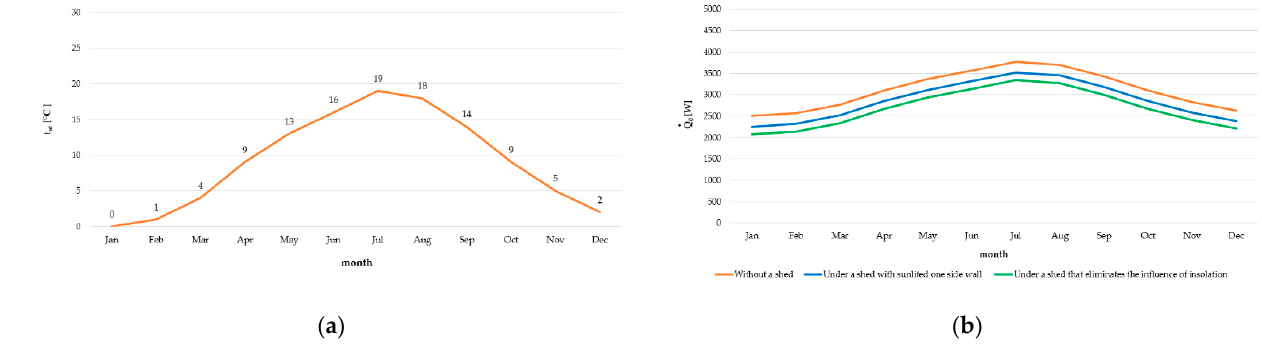
Figure 5. The average ambient temperature fluctuation during the year in Szczecin city ( a ) and dependence of daily total heat gains of the refrigerated semi-trailer on the ambient temperature in particular months ( b ).